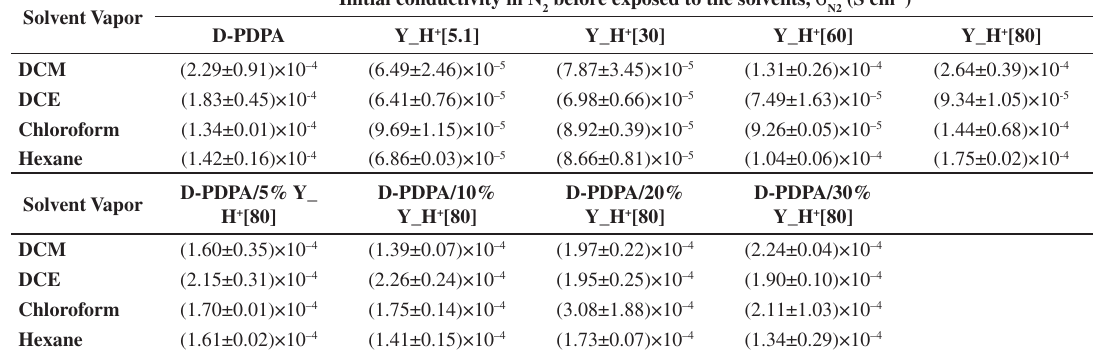
Table 2. The initial electrical conductivity of D-PDPA, Y_H + , D-PDPA/Y_H + [80] in N 27±1°C and 1 atm.